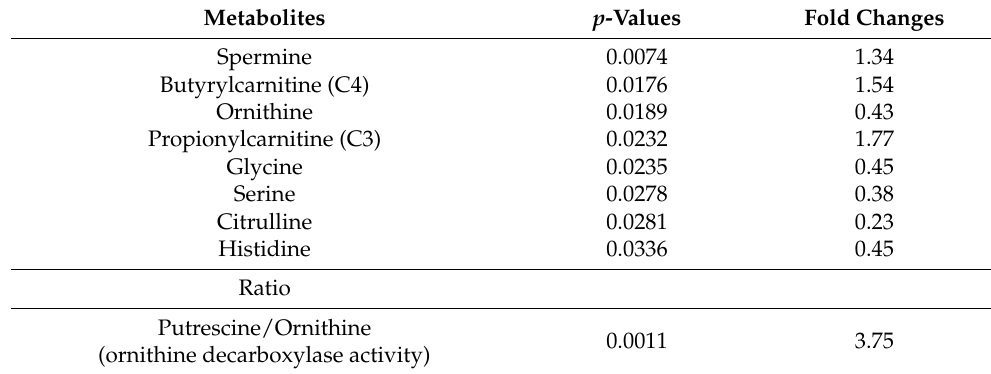
Table 2. List of metabolites with significant modification of concentrations in tears of patients with active compared to inactive